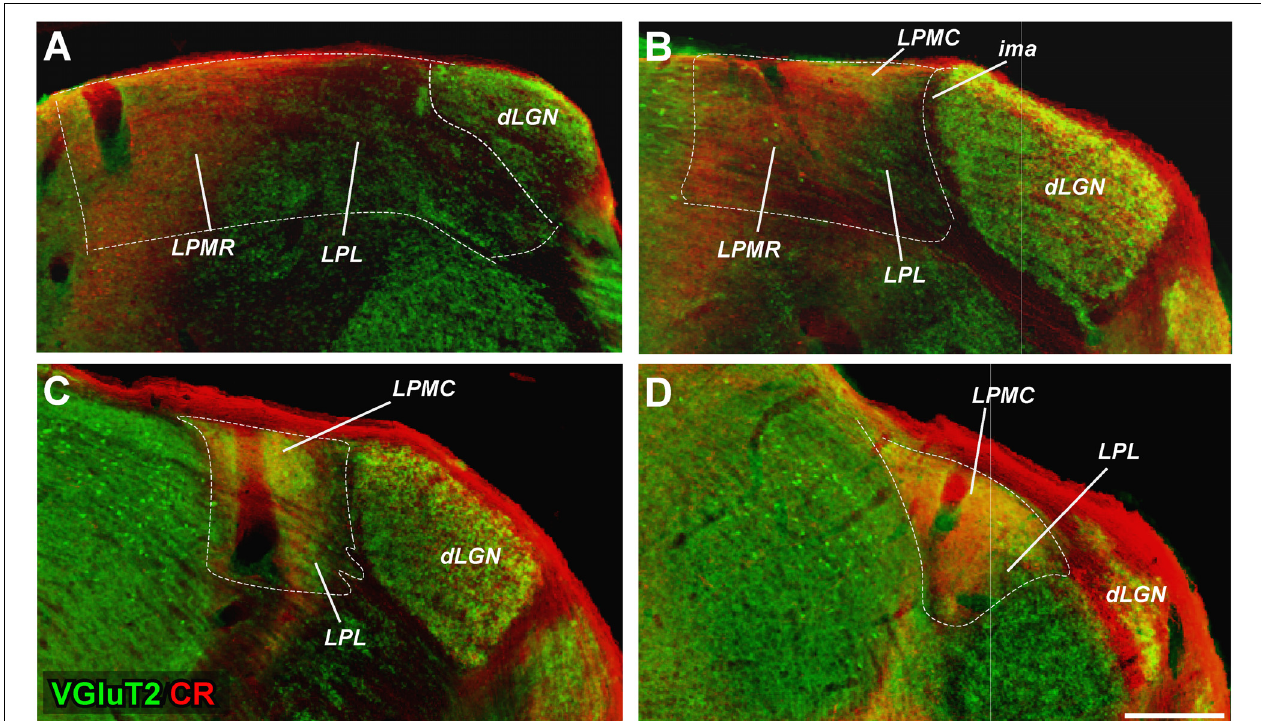
FIGURE 2 | Delineation of LP subdivisions from the overlay of VGluT2 and CR immunostaining images. (A–D) Images from adjacent sections immunostained, respectively, for VGluT2 and CR immunolabeling (colored in red and green, respectively) are overlaid. This analysis reveals that LPMR is VGluT2-poor and CR-rich (red in the merged images), LPL is VGluT2 and CR-poor (green), and LPMC is both VGluT2 and CR rich